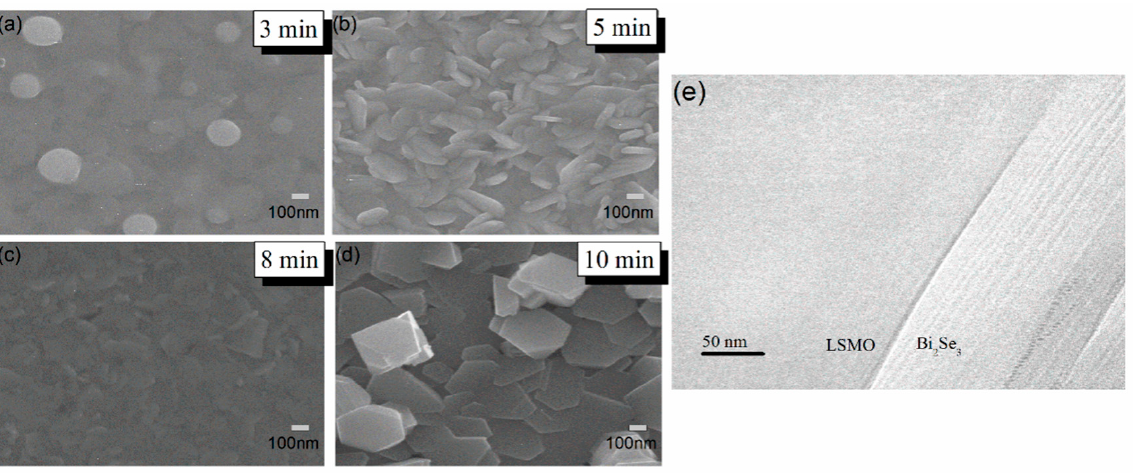
Figure 1. ( a ) X-ray diffraction spectra of Bi 2 Se 3 films on LaSrMnO 3 /LAO with different deposition times. ( b ) X-ray rocking curve of the (006) peak of the Bi 2 Se 3 film of 8 min. Table 1. The EDX and thickness results of the Bi 2 Se 3 films with deposition time.